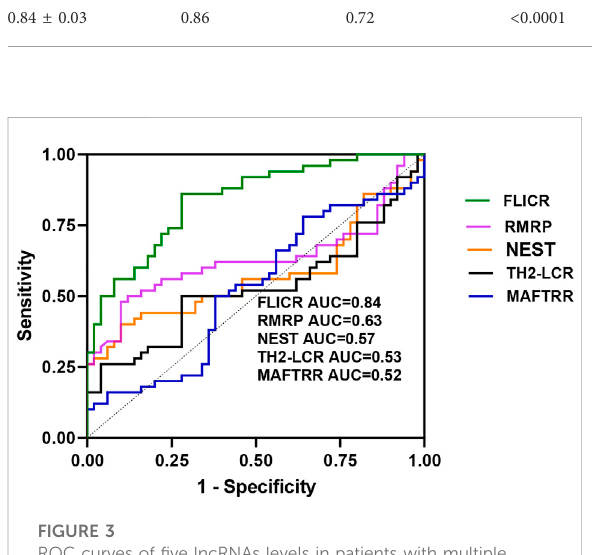
TABLE 6 The results of ROC curve analyses for two differentially expressed lncRNAs in patients with MS disease. FLICR AUC±SD